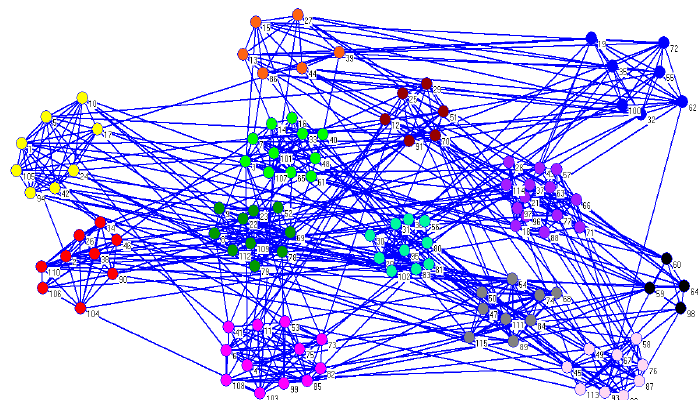
Figure 7. (Color online) Detected communities on the American college football network (when λ = 0.81, NMI = 0.9126).